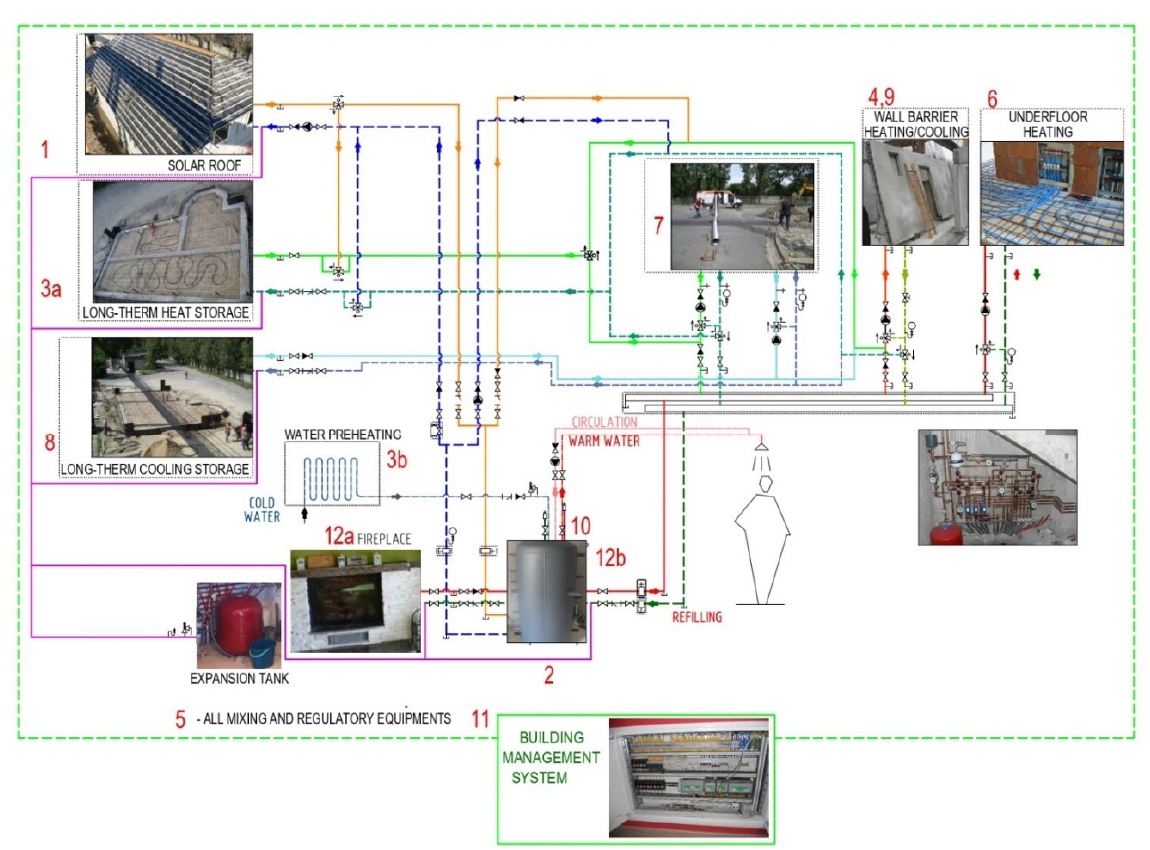
Figure 31. Simplified wiring diagram of the technical solution of the energy systems of the IDA I prefabricated house prototype [1]. 1—solar absorber (energy/solar roof), 2—short-term heat storage,